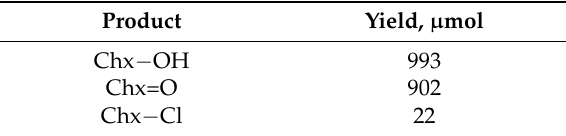
Table 11. Products from the 6-h irradiation of 3.0 mL of C 6 H 12 /CH 2 Cl 2 (50/50 vol%) in sunlight,